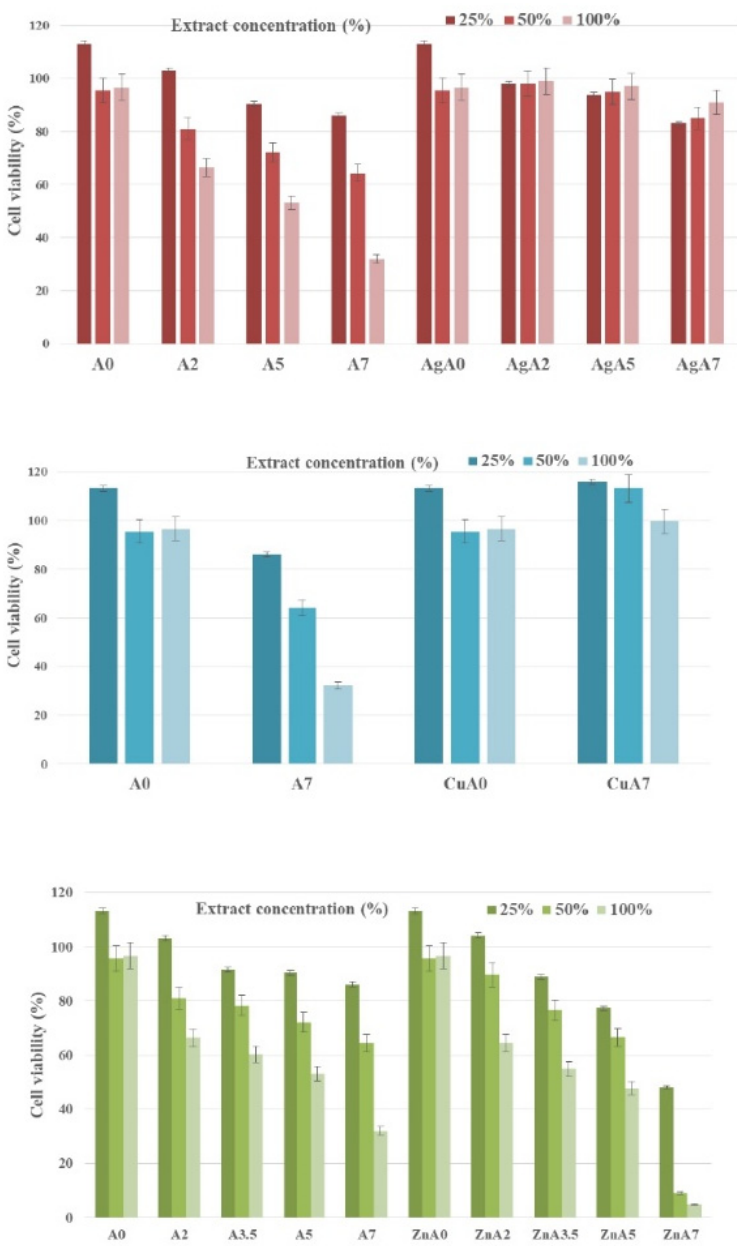
Figure 1. Cell viability for hydrogel A series based on acrylate and itaconic acid and A series loaded with silver, copper and zinc ions.